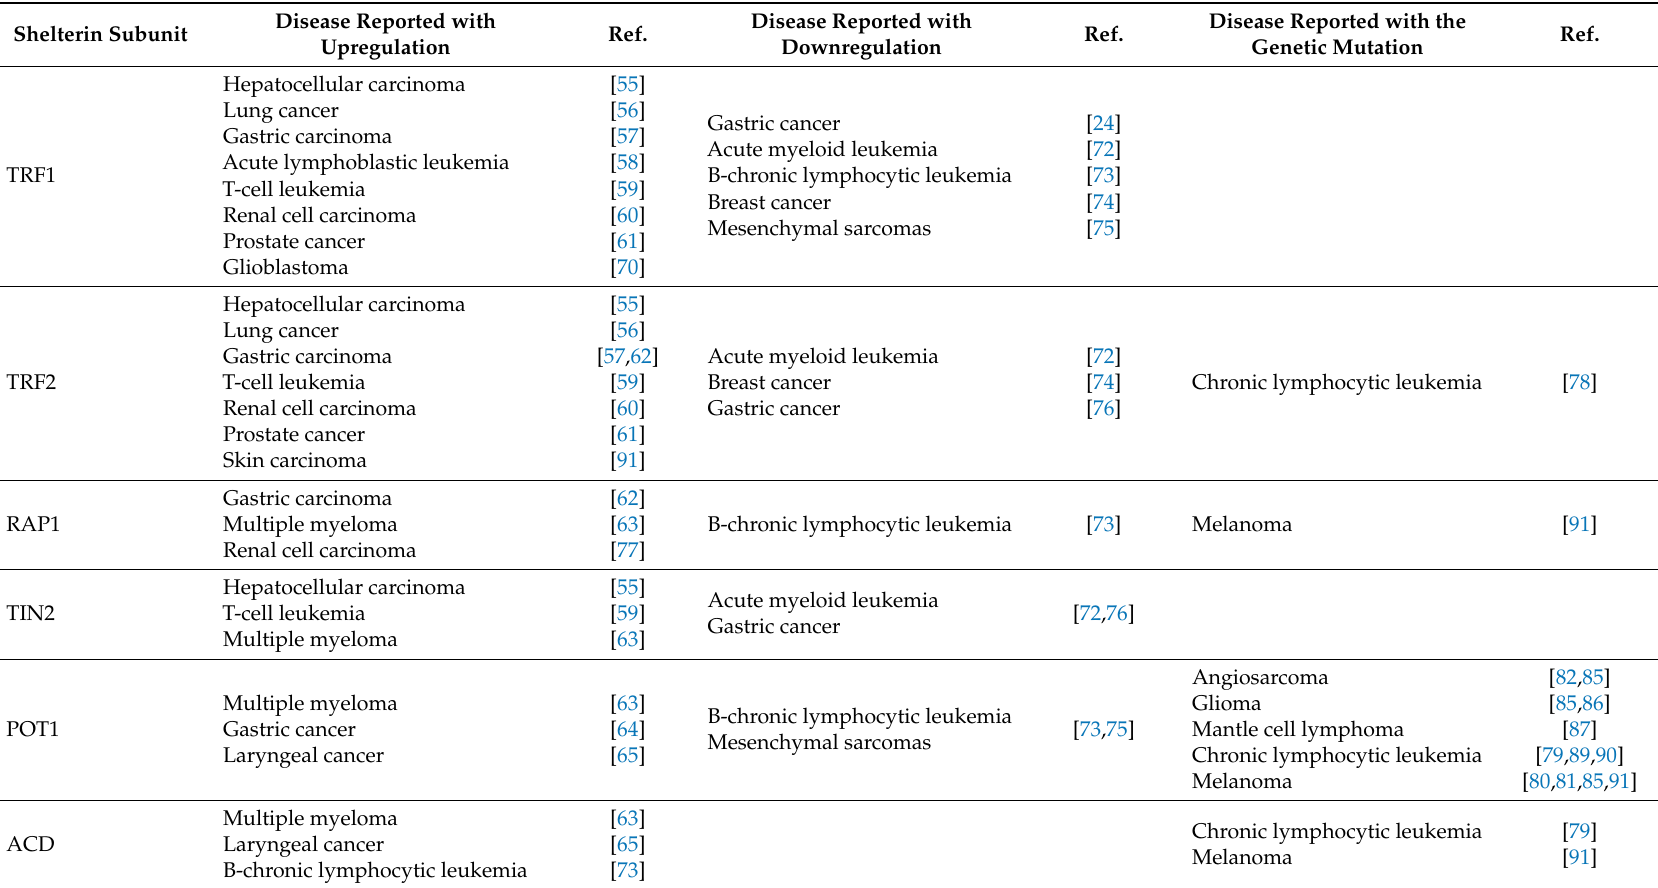
Disease Reported with the Ref. Genetic Mutation